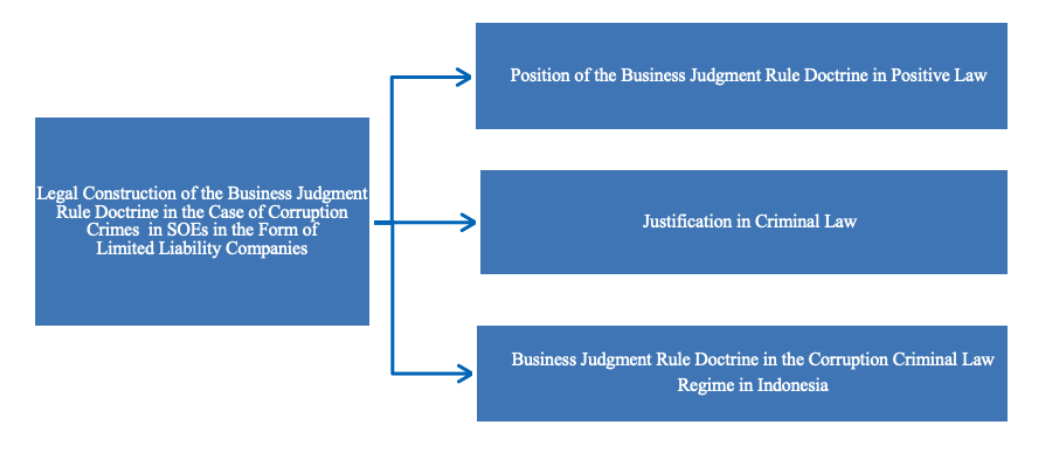
Figure 1: Legal Construction of the Business Judgment Rule Doctrine in the Case of Corruption Crimes in SOEs in the Form of Limited Liability